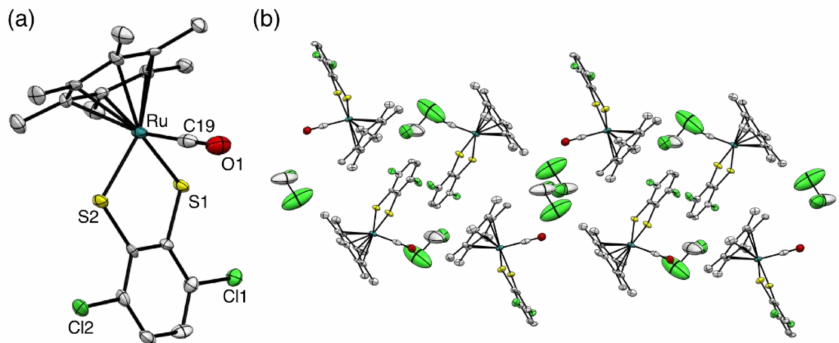
Figure 2. ( a ) ORTEP drawing of 2c with thermal ellipsoids at the 50% probability level. Hydrogen atoms and dichloromethane molecules are omitted for clarity. Color codes: light grey, C; red, O; yellow, S; green, Cl; turquoise blue, Ru. ( b ) Packing structure of 2c